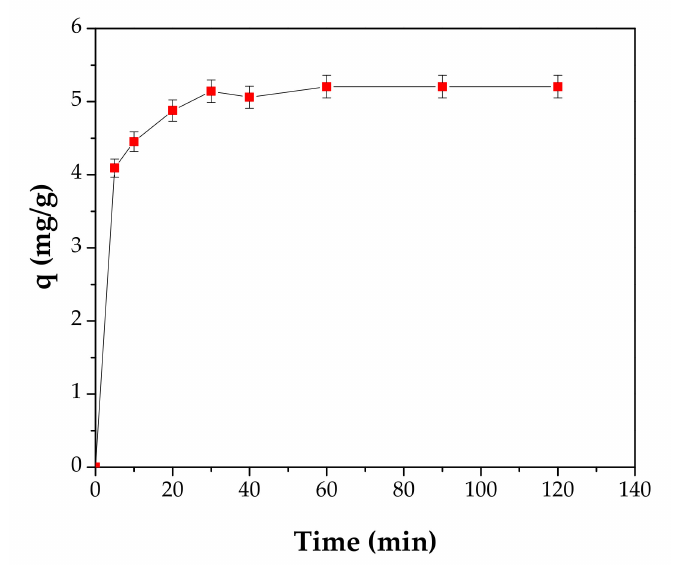
Figure 10. E ff ect of contact time on Cd 2 + adsorption, C 0 70 mg / L, pH 5 and 8 g / L adsorbent